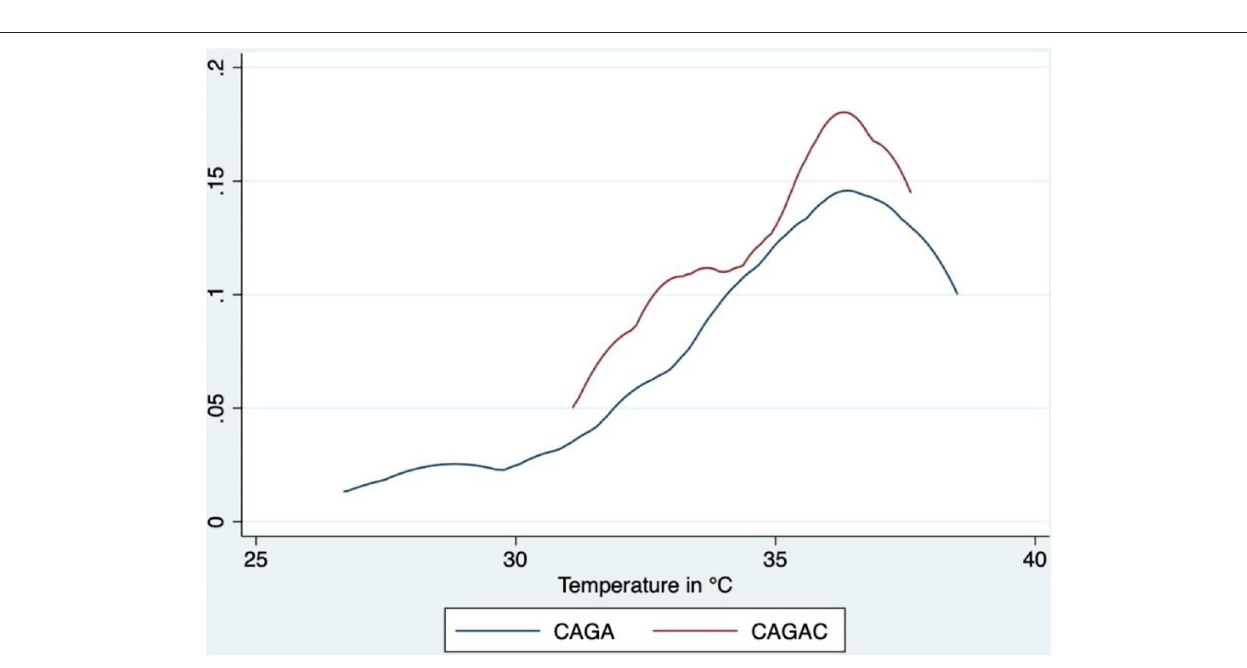
recorded in CAGAs and CAGACs differed by − 0.10 ◦ C ( p = 0.87) and 0.52 ◦ C ( p = 0.38),